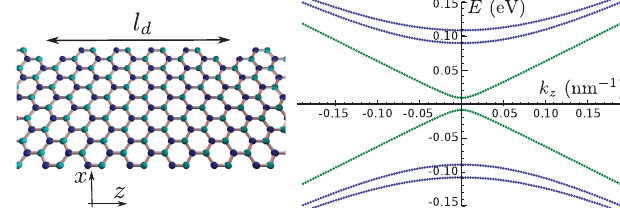
FIG. 3. Defects on the edges of a metallic armchair GNR ( N ¼ 82 ), resulting in the opening of a gap at zero energy. In the numerical diagonalization, the defects are modeled by omit- ting two atoms on the edges, which is assumed to be periodic ffiffiffi p ¼ 5 a . We see that the spectrum changes only 3 with period l d slightly, and the qualitative features of a metallic armchair GNR are